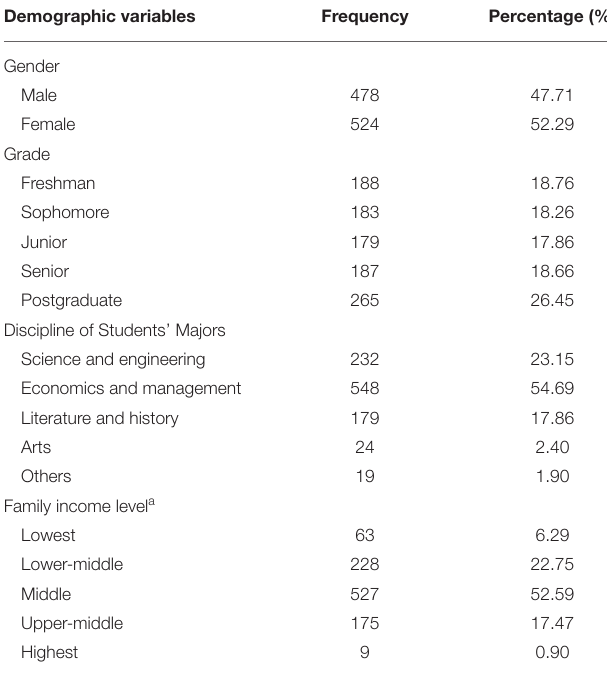
TABLE 1 | Demographic information of the current sample ( N =